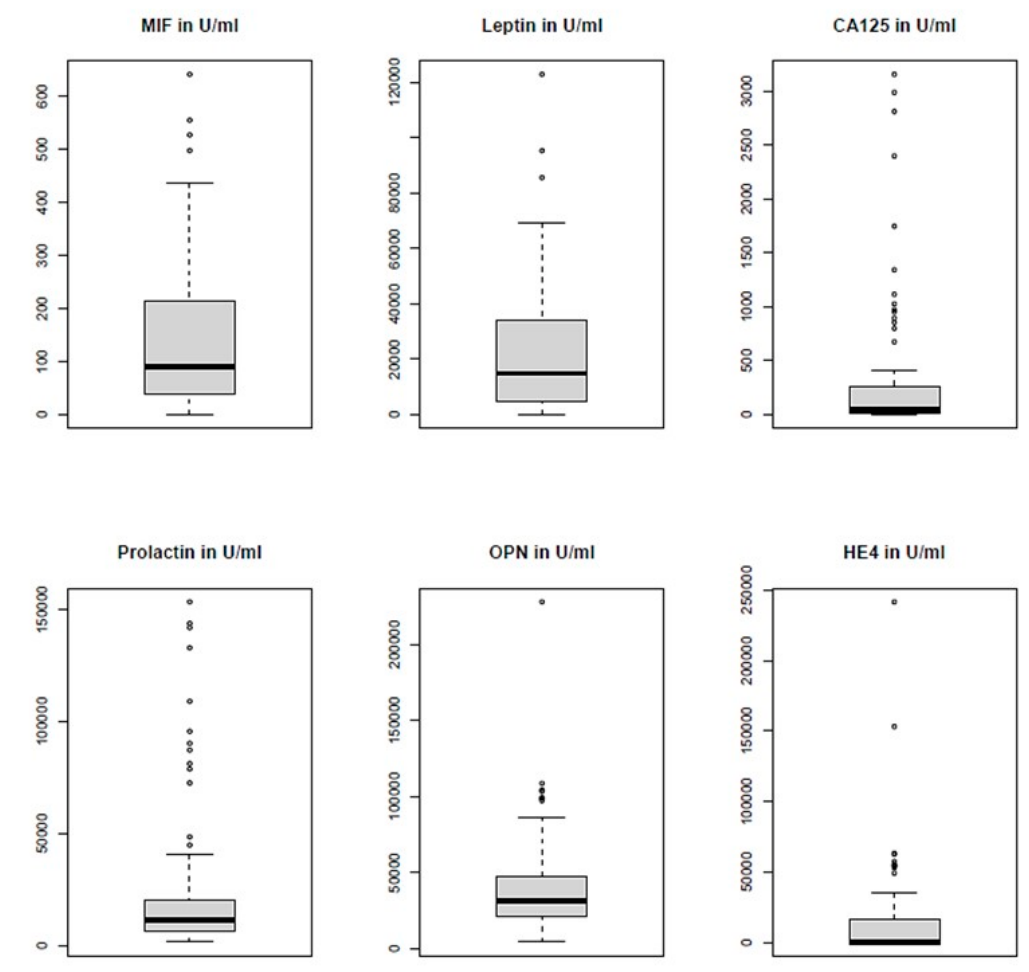
Figure A1. Visualization of the protein values in the validation cohort.